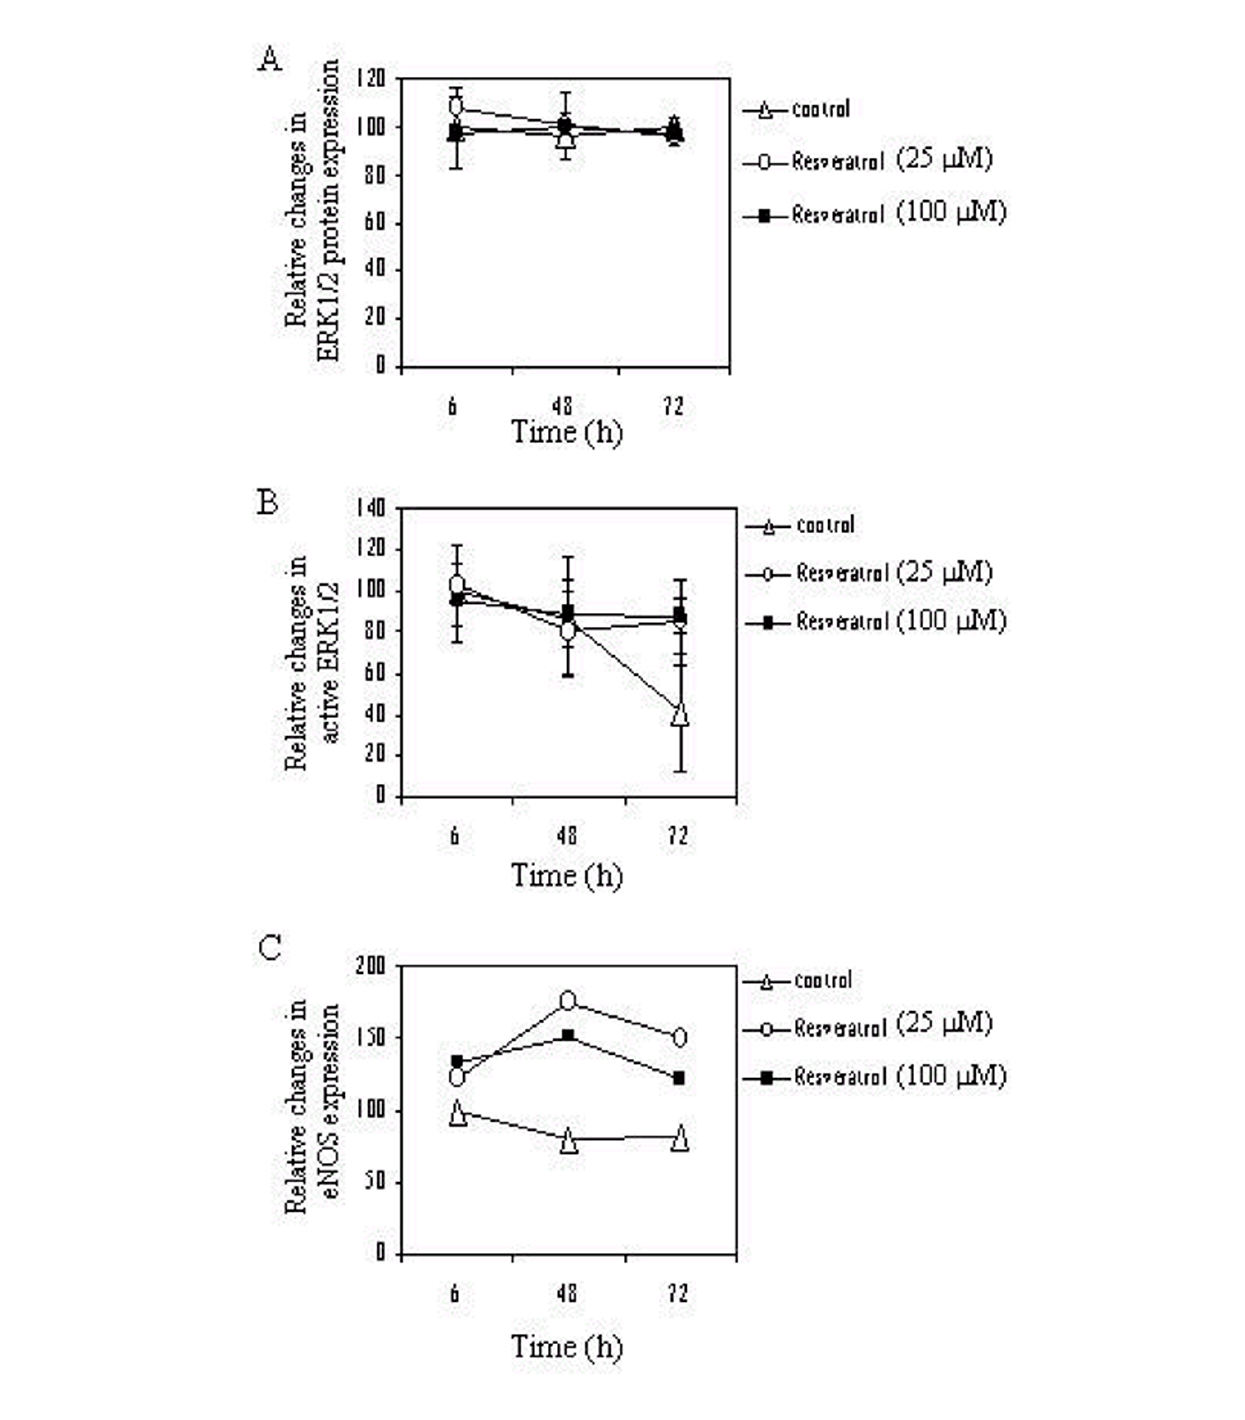
Figure 6 Time-dependent relative changes in expression of total ERK1/2, active ERK1/2, and eNOS. Intensity of signals corresponding to total ERK1/2 (panel A), active ERK1/2 (panel B), and eNOS (panel C) obtained by western blot analysis, similar to those shown in Figure 5, was quantified by actin-adjusted image analysis and plotted as a function of time of treatment with 25 µ M and 100 µ M resveratrol. The control value at 6 h was set at 100. The results represent the average of two experiments, each analyzed in duplicate or